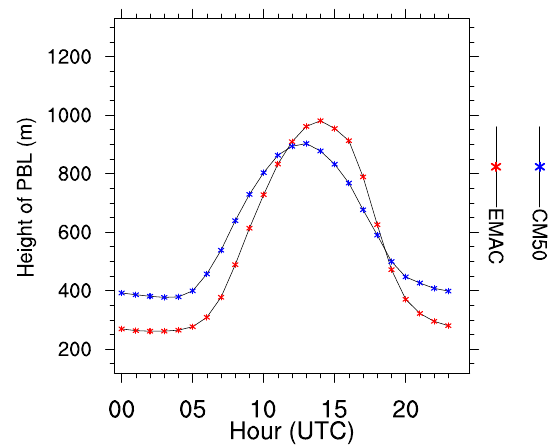
Figure 16. Height of the planetary boundary layer for June 2008 in m averaged over all non-mountain